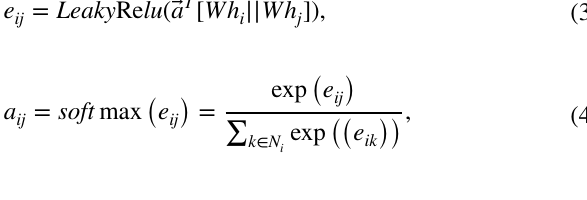
Fig. 2 Representation of the Boolean formula in an undirected